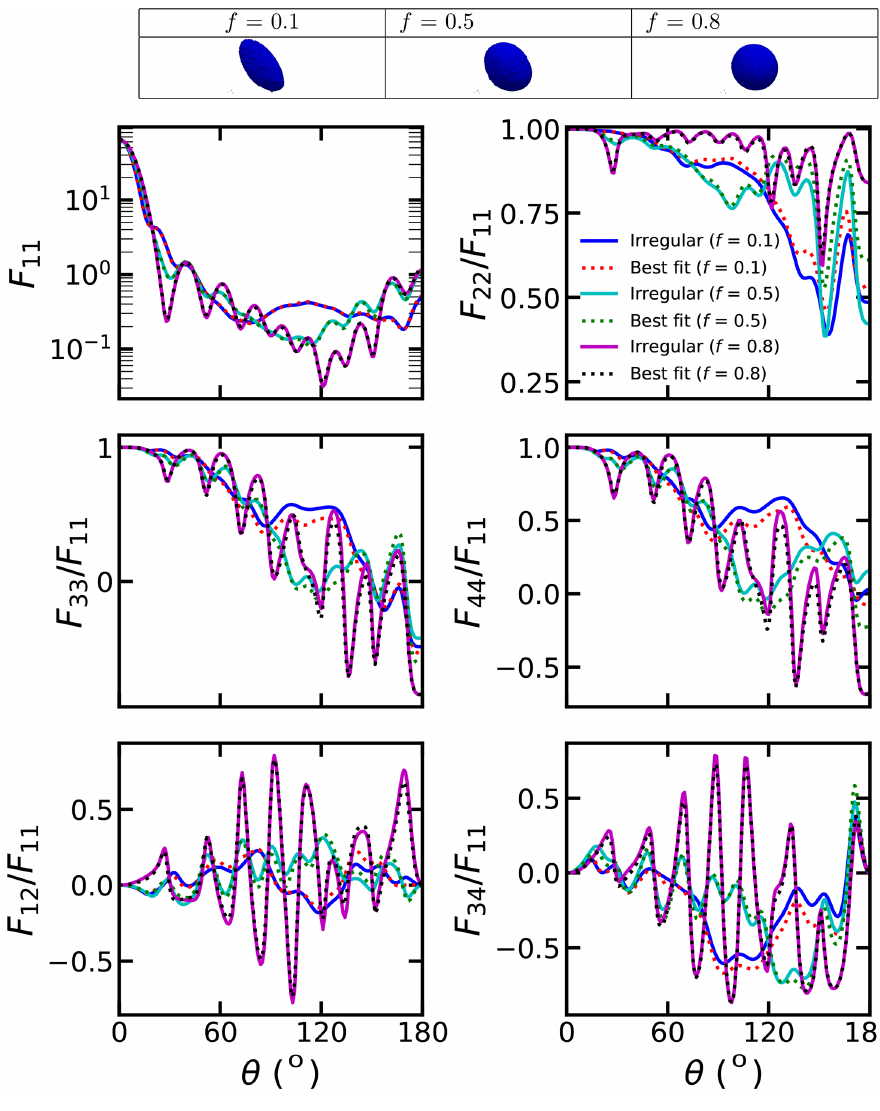
Figure 7. Similar to Fig. 4 but for R = 1. Table 2. The scattering or extinction cross-section of dust with irregular